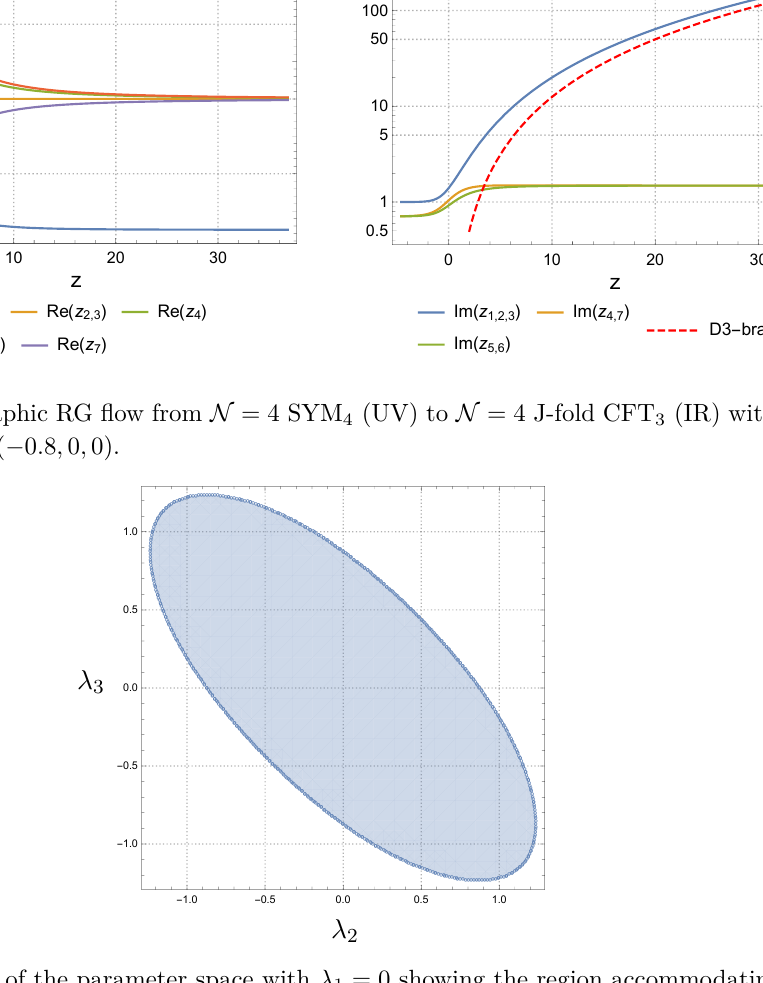
in the IR. Sections with λ = 0 or λ = 0 3 2 3 i